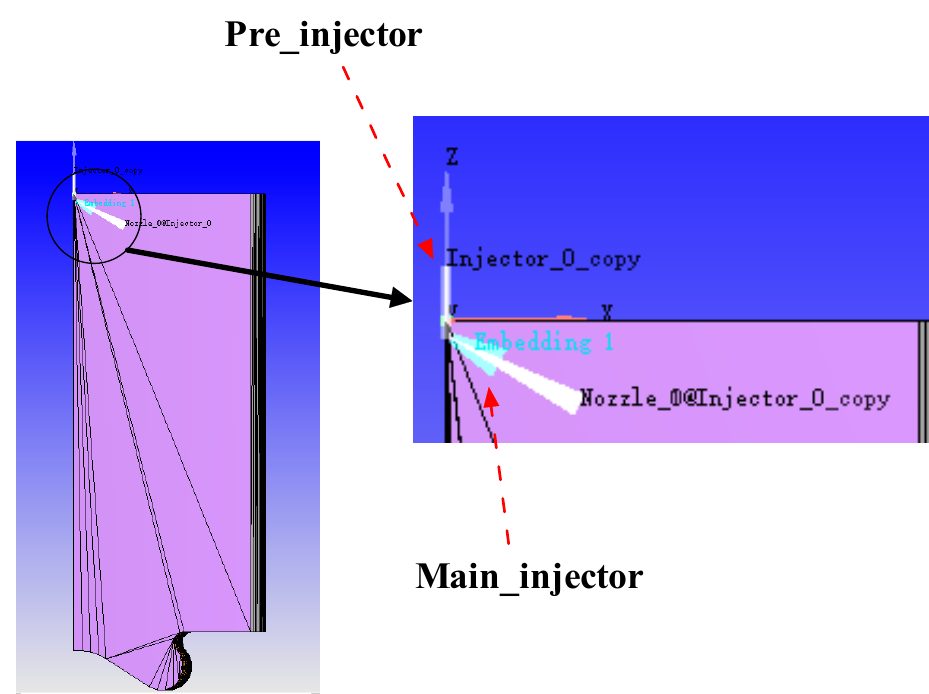
Figure 6. The layout of the injector location in the CONVERGE environment.